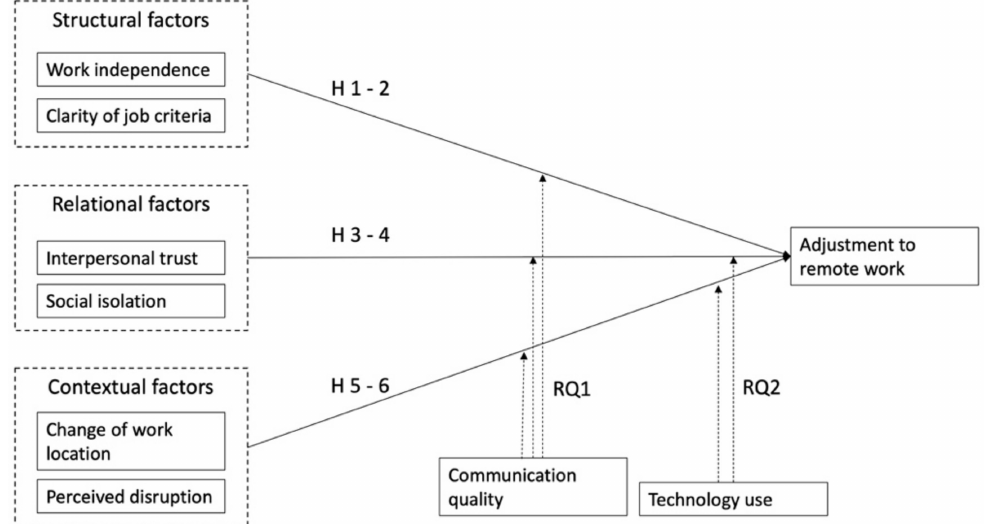
Figure 1. Hypothesized